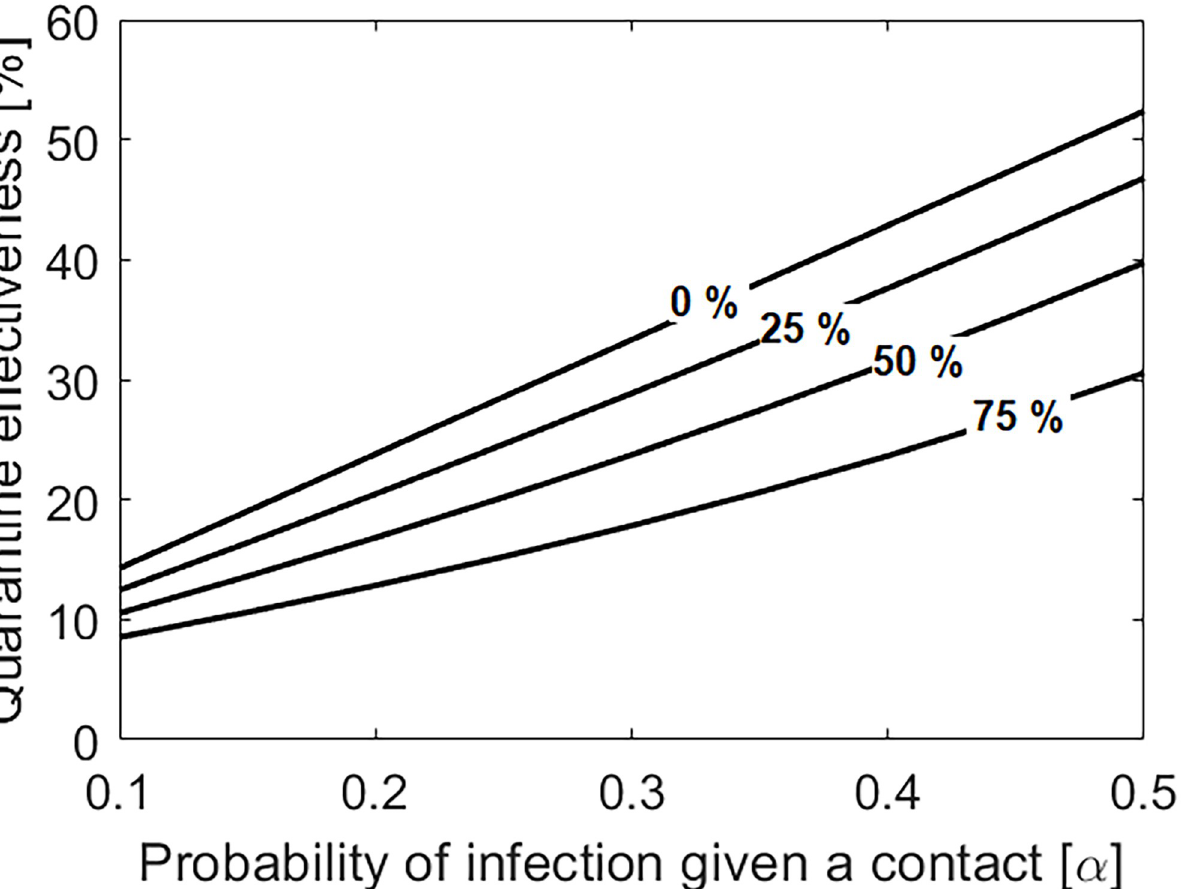
Fig 4. Quarantine effectiveness, defined as the percentage of quarantined individuals that develop an infection, as a function of the probability of infection given a contact ( α ). Different curves represent different proportions of immune individuals in a population, where we consider that 0%, 25%, 50% or 75% of the population is